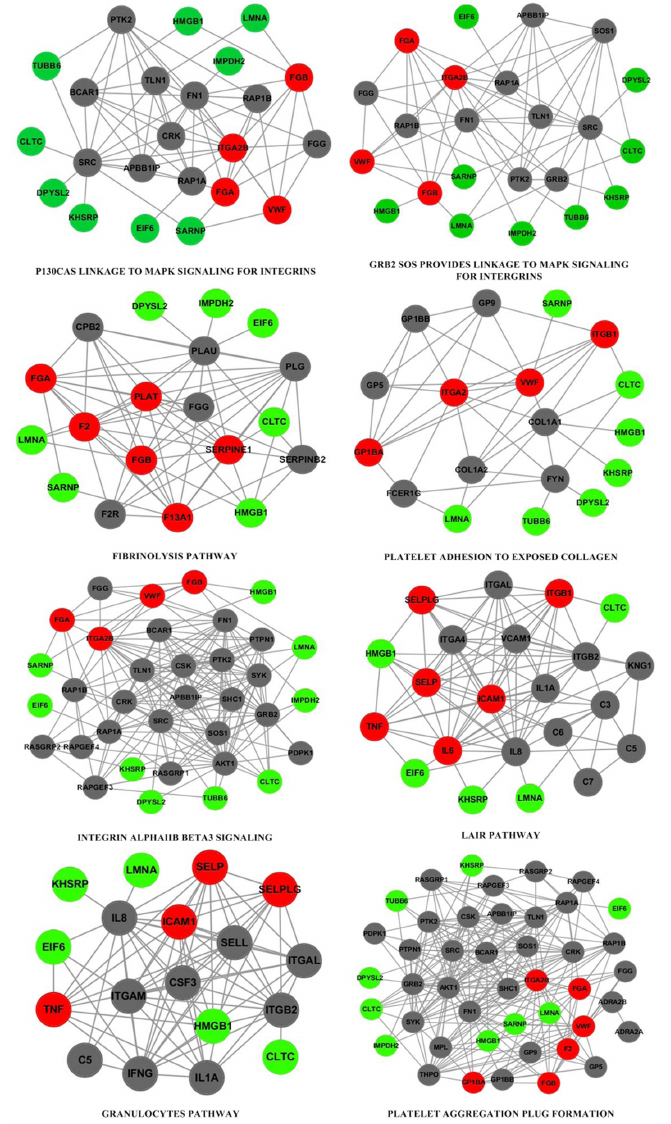
Fig 3. Eight ischemic stroke associated pathway sub-networks regulated by CYNA, where red circles represent ischemic stroke associated genes, green circles represent CYNA's targets, gray circles represent other genes on the